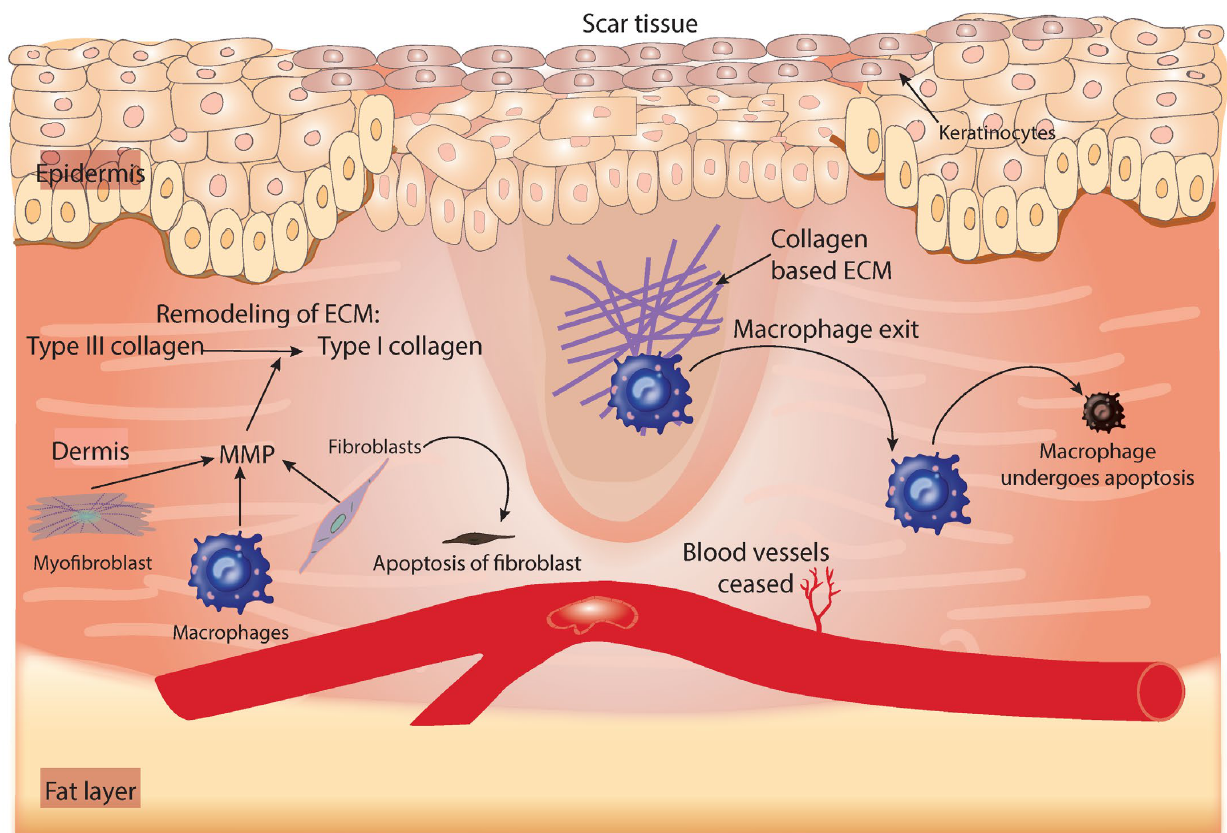
Figure 4. Summary of the process that occurs during the tissue-remodeling phase of healing. The release of MMP from fibroblasts, macrophages, and myofibroblasts helps to remodel the ECM by converting type III collagen into type I collagen. Fibrin-based ECM made during the first phase of healing is replaced by collagen-based ECM. The very few cells that remain in the wound are removed by apoptosis and neovascularization ceases. ECM, extracellular matrix; MMP, matrix metalloproteinase.